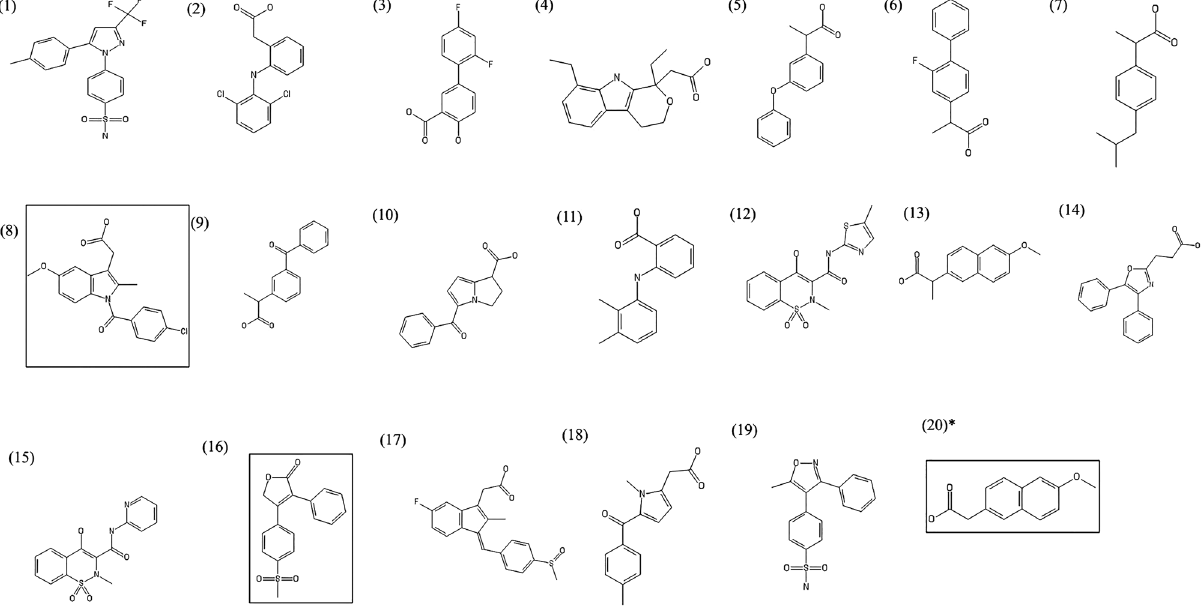
Figure 2. Structure of 19 NSAIDs and 1 prodrug. (1) Celecoxib (2) Diclofenac (3) Diflunisal (4) Etodolac (5) Fenoprofen (6) Flubiprofen (7) Ibuprofen (8) Indomethacin (9) Ketoprofen (10) Ketorolac (11) Mefenamic acid (12) Meloxicam (13) Naproxen (14) Oxaprozin (15) Piroxicam (16) Rofecoxib (17) Sulindac (18) Tolmetin (19) Valdecoxib *(20): Nabumetone (prodrug of 6MNA). The three NSAIDs in box line are the most potent NSAIDs candidates against and 78 edges. According to the KEGG pathway enrichment analysis, 13 target proteins were connected to 26 signaling pathways (False Discovery Rate < 0.05). Table 2 showed the description of 26 signaling pathways. Fig- ure 5 displayed that 13 out of the final 26 overlapping target proteins were strongly associated with 26 signaling pathways against COVID-19; moreover, the RAS signaling pathway with the lowest Rich factor was identified as a hub signaling pathway.